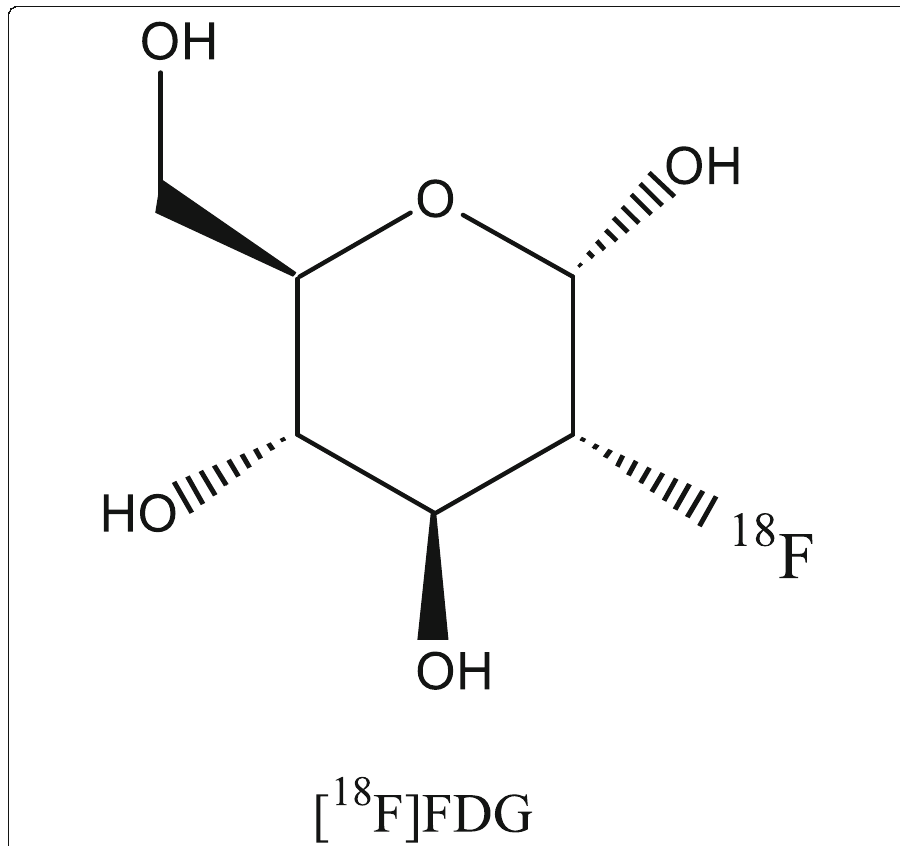
Fig. 1 Chemical structure of [ 18 F]Fluordesoxyglucose ([ 18 F]FDG)